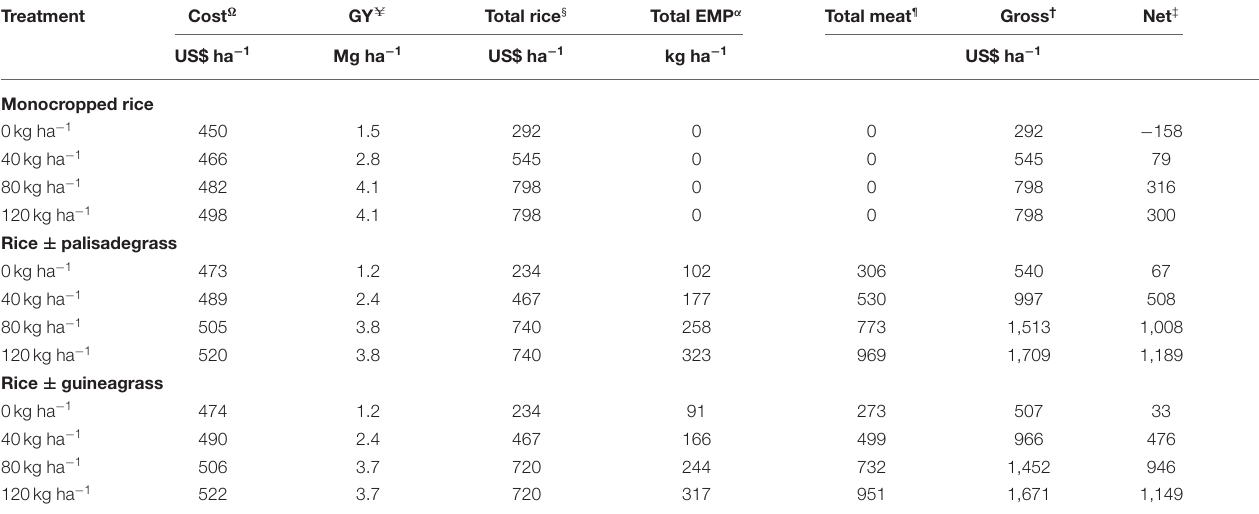
TABLE 4 | Economic evaluation of monocropped upland rice, upland rice intercropped with palisadegrass and upland rice intercropped with guineagrass as a function of sidedress nitrogen rates for upland rice (average of three growing seasons). Treatment Cost (cid:127) GY U Total rice § Total EMP α Total meat ¶ Gross † Net ‡ US$ ha − 1 Mg ha − 1 US$ ha − 1 kg ha − 1 US$ ha − 1 Monocropped rice 0kg ha − 1